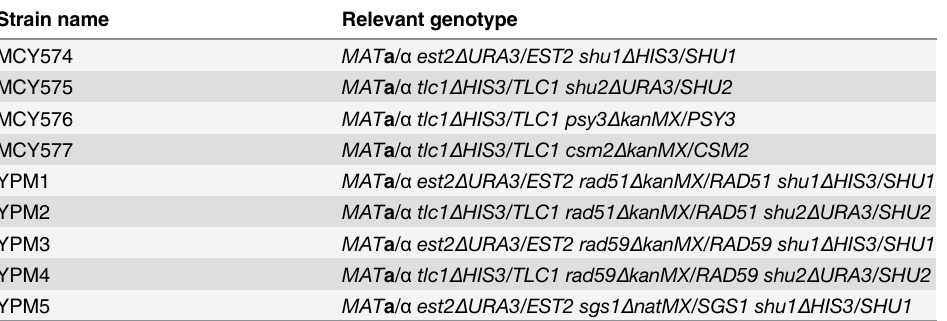
Table 1. Yeast strains used in this